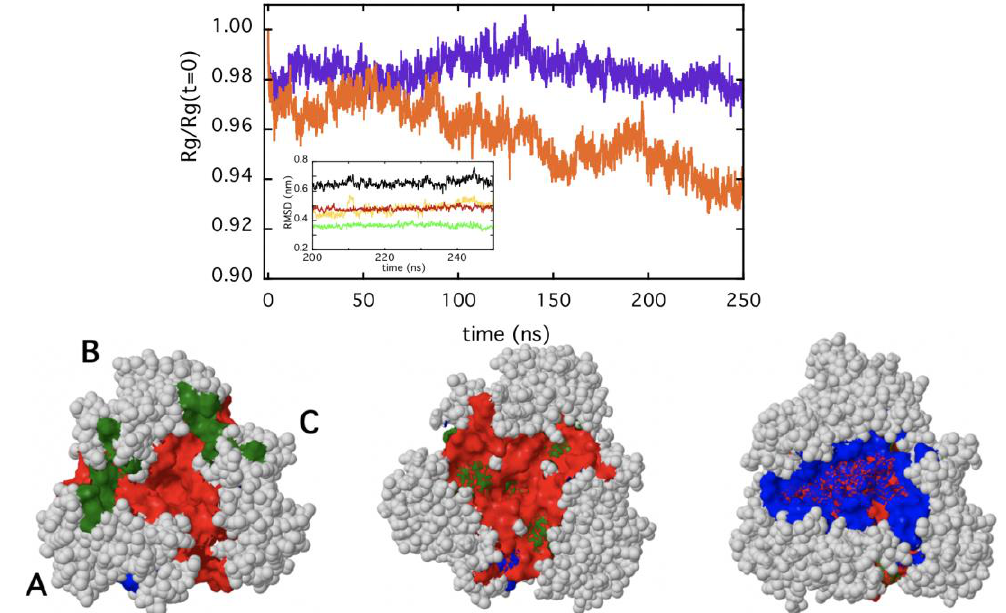
Figure 8. Upper panel: Relative gyration radius of TRAF2-C (with respect to the value at t = 0) obtained in the MD simulation at two temperatures, namely T = 15 °C (purple) and T = 37 °C (orange). In the inset, the root mean square deviation (RMSD) at 37 °C, for the last 50 ns of simulation is reported, for trimeric TRAF2-C (black line) and for the three subunits (A, green; B, yellow; C, red). Lower panel: The cartoons represent the main surface cavities distribution (top view) of trimeric TRAF2-C at three different times (t = 0, left; t = 50 ns, middle; t = 220 ns, right) of the molecular dynamics simulation performed at 37 °C. The most relevant surface cavities (in size and depth descending order) are reported in red, green, and blue, respectively. The analysis was performed using the 3D-surfer 2.0 software [35].